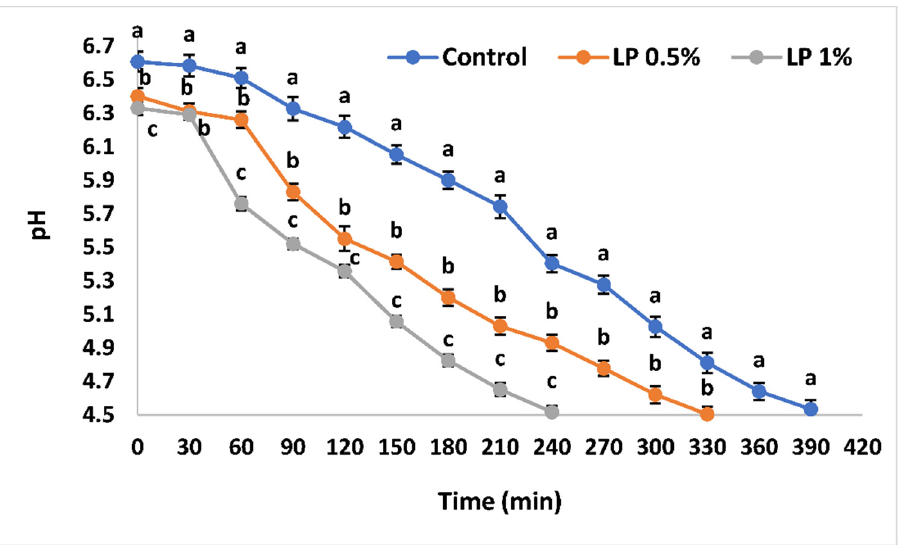
Figure 1. Effect of PFPP on acidification kinetic profiles of labneh. Different lowercase superscripts indicate significant ( p < 0.05) differences between the values for different treatments. LP: Labneh supplemented with PFPP. Vertical bars present the standard division of the treatment means. Table 1. Effects of PFPP addition at various concentrations on the fermentation kinetics of labneh.